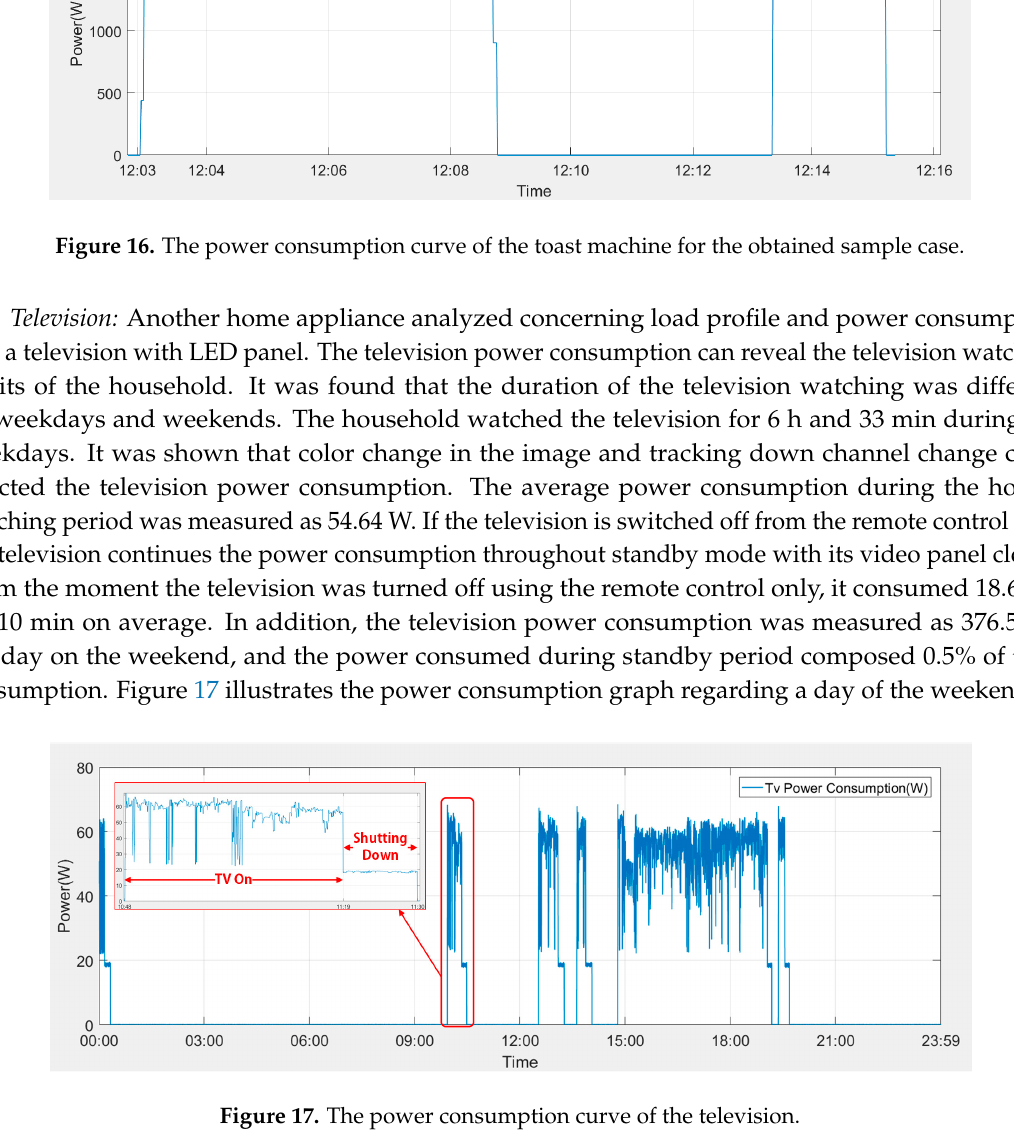
Figure 15. The power consumption curve of the range hood for fan speed ( a ) level 1, ( b ) level 2, and ( c ) level 3.